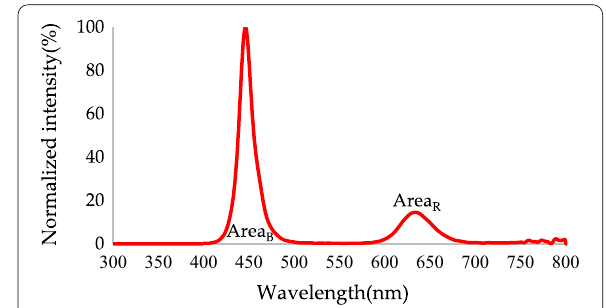
Fig. 9 Normalized blue light without RCPEF conversion to green